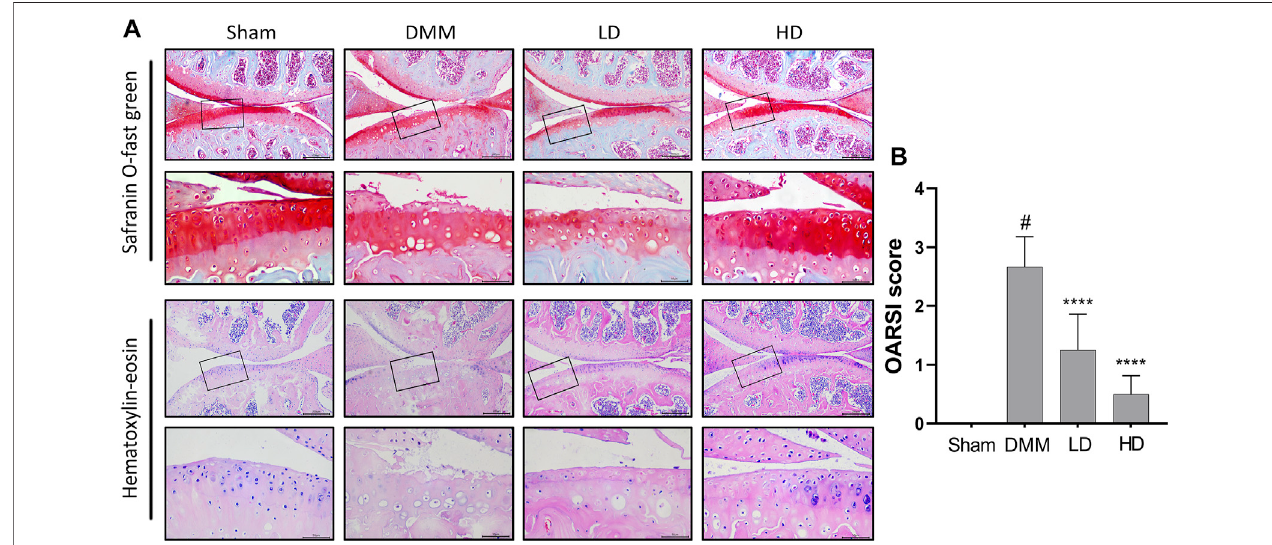
FIGURE 5 | Effect of CEP on cartilage degradation in DMM-induced OA pathogenesis. (A) Representative images of safranin O staining and H&E staining of knee joints in four groups ( n = 6 per group). Scale bar = 200 µm. The framed area in each picture is shown below at a higher magni fi cation. (B) Quantitation of OA severity by the OARSI score for mice in Figure 5A . LD and HD represent the dose of 5 and 15 mg/kg CEP, respectively. Values are expressed as mean ± SD, n = 6. # p < 0.05 vs. sham group, and **** p < 0.001 vs. OA group.